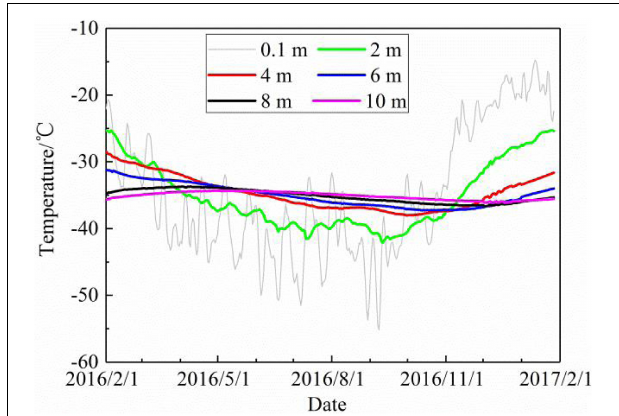
FIGURE 7 | Daily average snow temperatures at different depths at Taishan Station from February 2016 to January 2017.